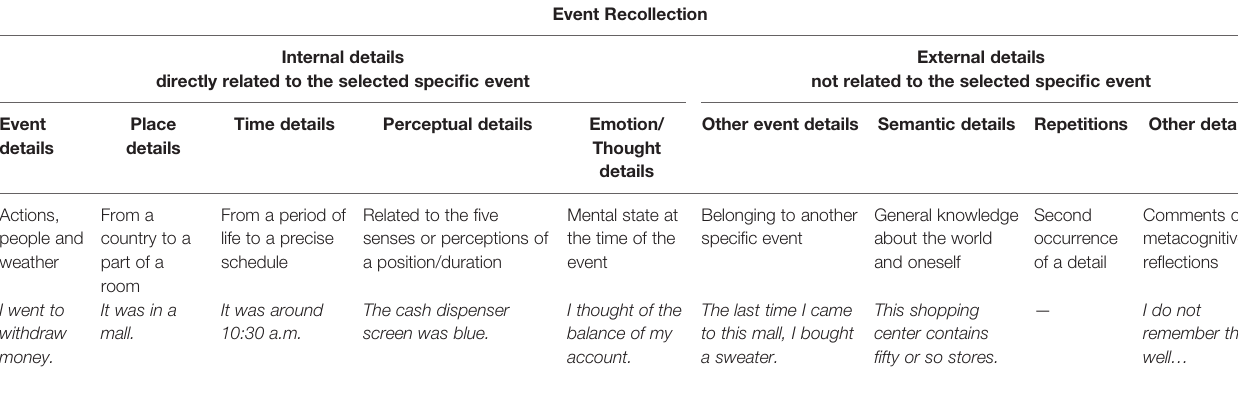
TABLE 2 | Examples of details for each of the categories described in the scoring method of the Autobiographical Interview (Levine et al., 2002). Event